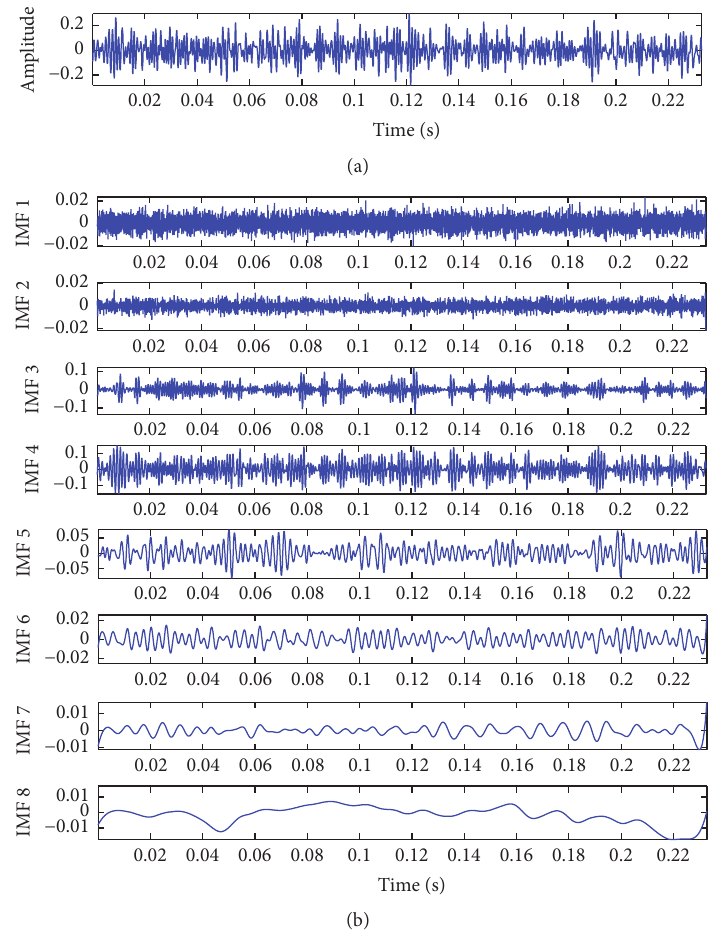
Figure 7: (a) Denoised signal after FNLM and (b) first 8 IMF components after EEMD. Table 7: Recognition accuracies of the feature classification with different methods. Faults classification result Fault classification method